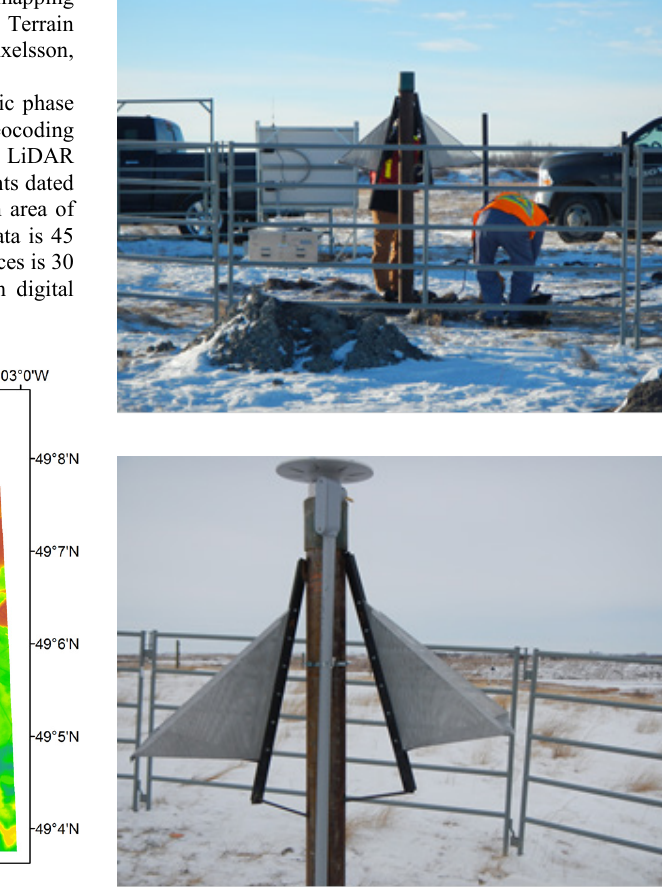
Figure 3. Detailed location of Aquistore injection site. The background is LiDAR DEM. Corner reflectors are marked with a flag and named: SITE (Aquistore injection site), NE1-NE2, NW1-NW2, SE1-SE3 and SW1.